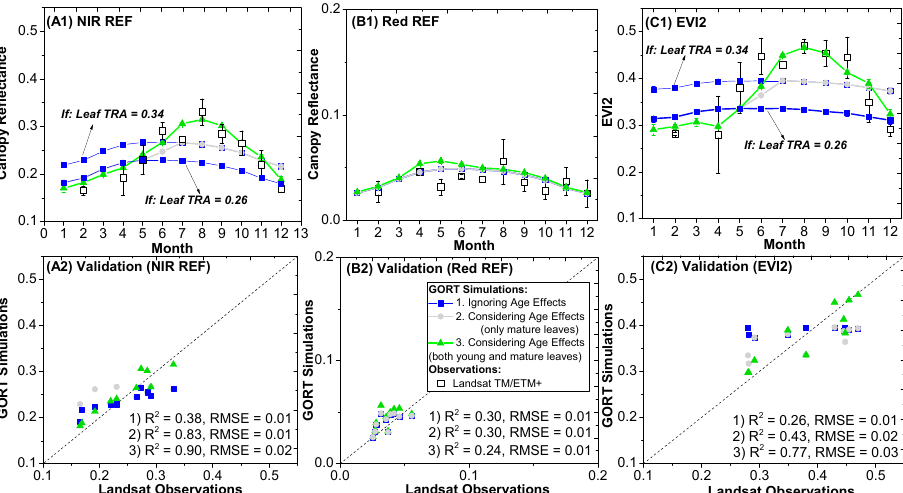
Figure 11. Aging effects of new leaves and mature leaves on seasonality of canopy signal trajectory in NIR band ( A1 ), red band ( B1 ) and EVI2 ( C1 ). With the exception of the differences in leaf optical parameters, all other input parameters for the GORT model are the same in three circumstances. We evaluated the simulated canopy signature with Landsat observations ( A2 – C2 ). Both the simulated results and Landsat observations are at a monthly step with the mean value and s.d. (from 2005 to 2015).